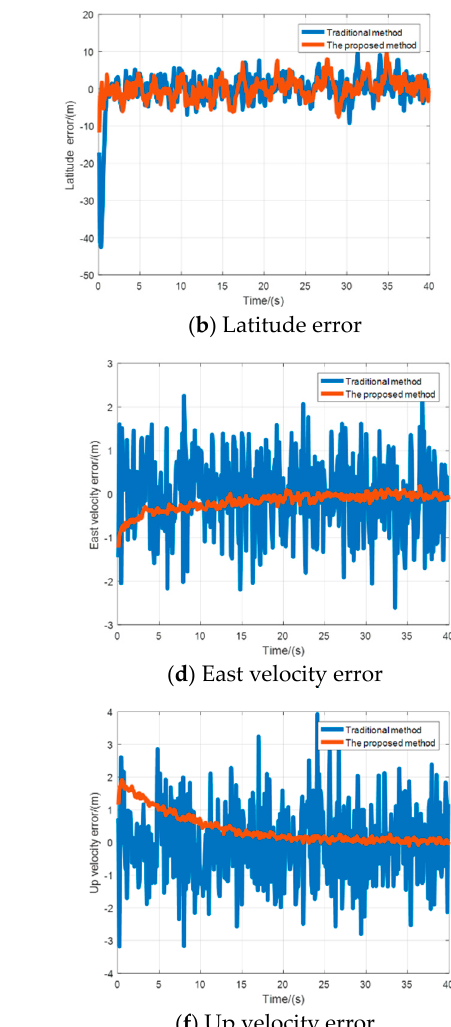
Figure 4. The positioning results in the static test in a Google map.